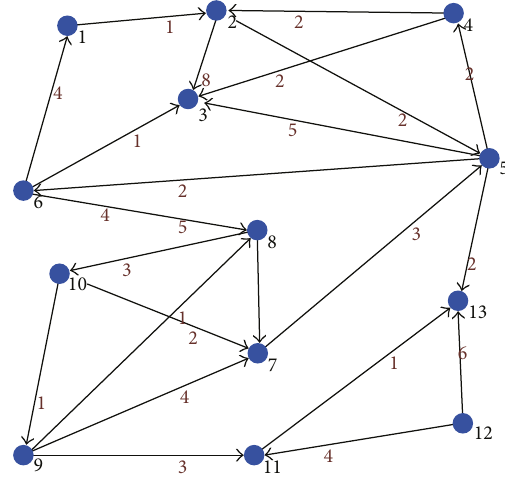
Figure 1: An example directed weighted network consisted of 13 nodes and 24 edges. The figure shows the connection relationships of the directed weighted network.